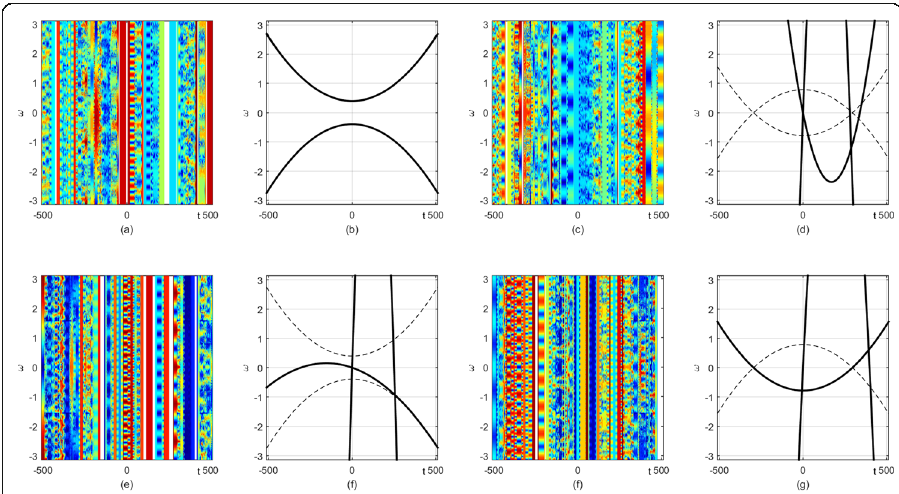
Fig. 13 Two-component cubic phase signal, STFTs (window with 160 samples), and IF estimates (thick line — estimates, dashed lines — true IFs) for K / N =6% of available samples: a , b Components with different amplitudes and separable in the TF plane; c , d Components with different amplitudes with IFs intersecting in the TF plane; e , f Components with same amplitudes and separable in the TF plane; g , h Components with same amplitudes with IFs intersecting in the TF